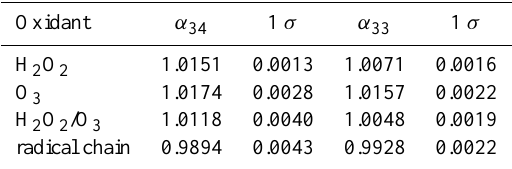
Table 3. Fractionation factors at 19 ◦ C for the aqueous oxidation of SO 2 by radical chain reaction initiated by Fe, H 2 O 2 bulk solution (from temperature-dependent regression), and H 2 O 2 /O 3 and only O 3 in aerosol